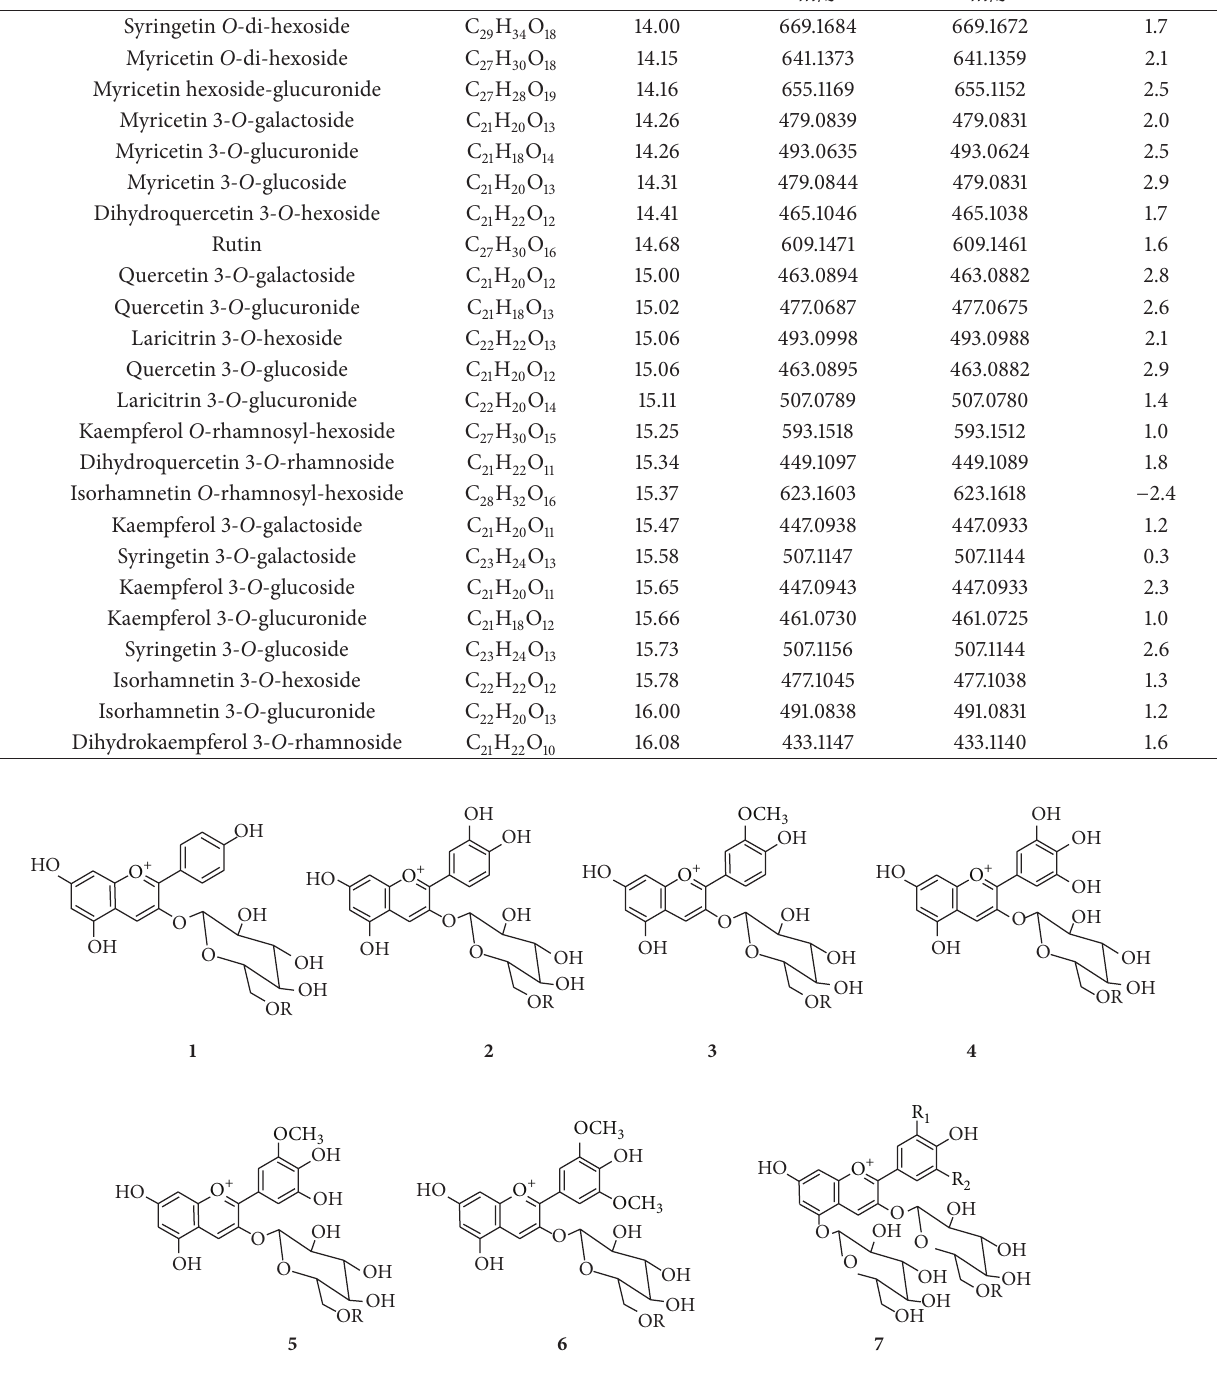
Figure 3: Principal grape anthocyanins. R: H, acetyl, p -coumaroyl, and caffeoyl; R 1 : H, OH, and OCH 3 ; R 2 : H, OH, and OCH 3 ; (1) pelargonidin-3- O -glucoside, (2) cyanidin-3- O -glucoside, (3) peonidin-3- O -glucoside, (4) delphinidin-3- O -glucoside, (5) petunidin-3- O - glucoside, (6) malvidin-3- O -glucoside, and (7) anthocyanidin-3,5- O